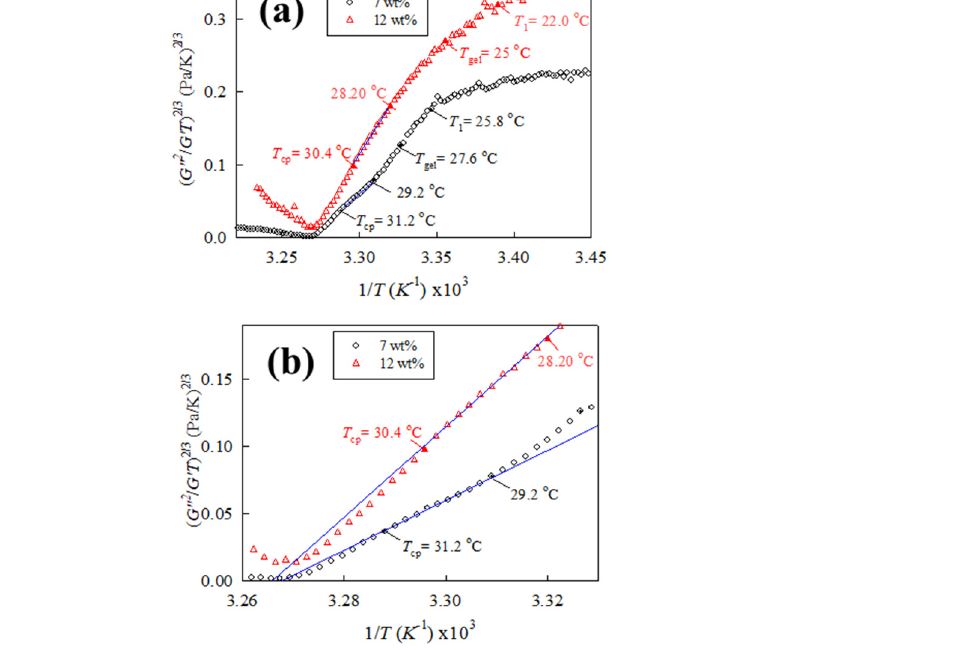
Figure 9. Determination of spinodal temperature of ( a ) 7 and 12 wt% a-PNIPAM solutions from linear dependence of ( G” 2 / G’T ) 2/3 versus 1/ T , and ( b ) enlarged portion of ( a ) for illustrating the linear regression to determine T s,gel , which can be evaluated by extrapolating the linear dependence to ( G” 2 / G’T ) 2/3 = 0 in the temperature range T gel < T < T cp to obtain the intercept with 1/ T axis, equaling to the reciprocal of the spinodal temperature, T s,gel . Linear regression is performed for temperatures above 29.2 and 28.2 °C for the 7 and 12 wt% solutions, respectively, giving rise to T s,gel of 32.6 and 32.9 °C. Table 1. Transition temperatures of a-PNIPAM aqueous solutions with different concentrations de- rived from the rheological measurements.